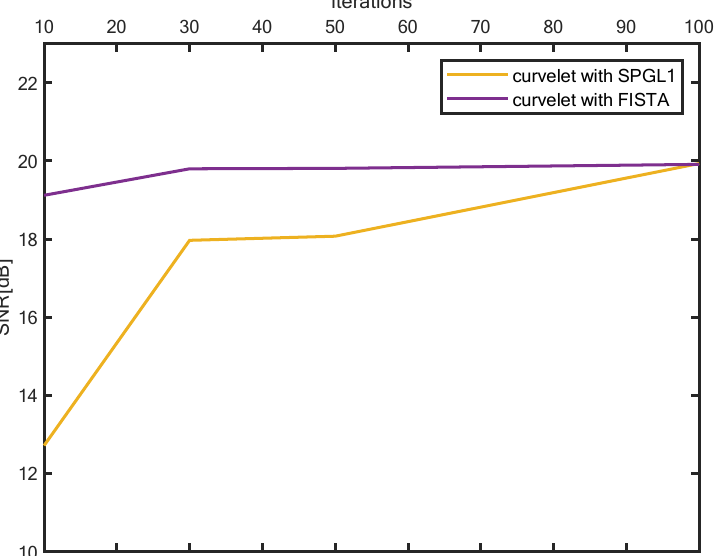
Figure 8. Comparison of Green’s functions according to Figure 7. ( a ) Green’s function without reconstruction calculated by irregular sampling over the source dimension and integrating over the receiver dimension; ( b ) Reconstruction in wavelet domain; ( c ) Reconstruction in Fourier domain; ( d ) Reconstruction in curvelet domain; ( e ) Green’s function for reference.